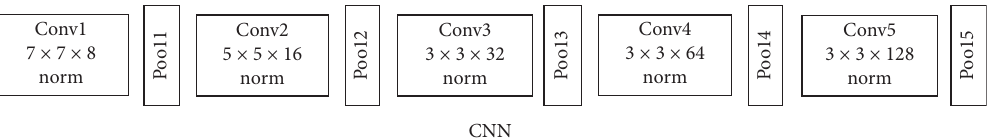
Figure 7: Structure of the convolutional neural network (CNN) used in this